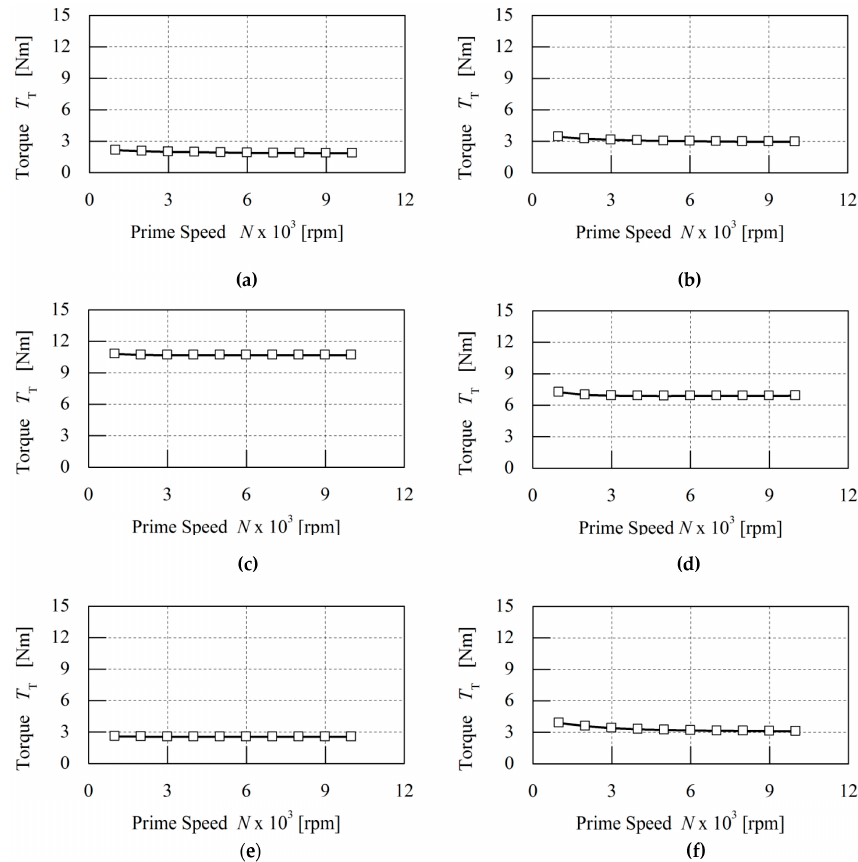
Figure 16. Torque distribution of DS-MGM with load: ( a ) Outer stator and outer field PM; ( b ) Outer field pm and outer iron ring; ( c ) Outer iron ring and prime PM; ( d ) Prime PM and outer iron ring; ( e ) Inner iron ring and inner field PM; ( f ) Inner field PM and inner stator.